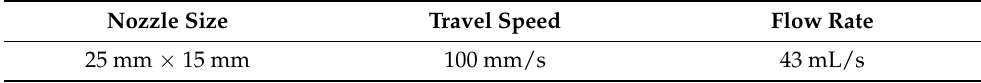
Table 1. Printing parameters used for the experiment.